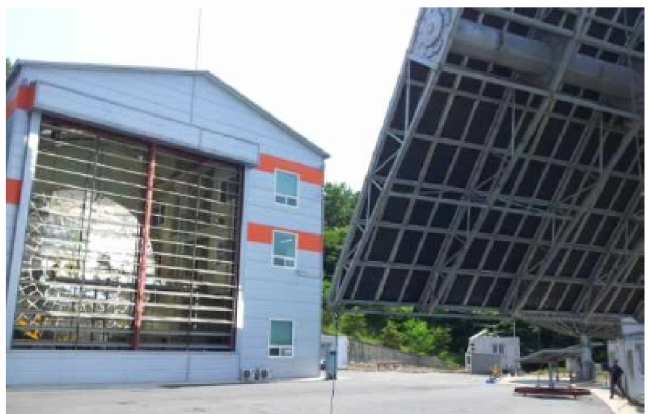
Figure 2. 40 kW solar furnace at KIER.